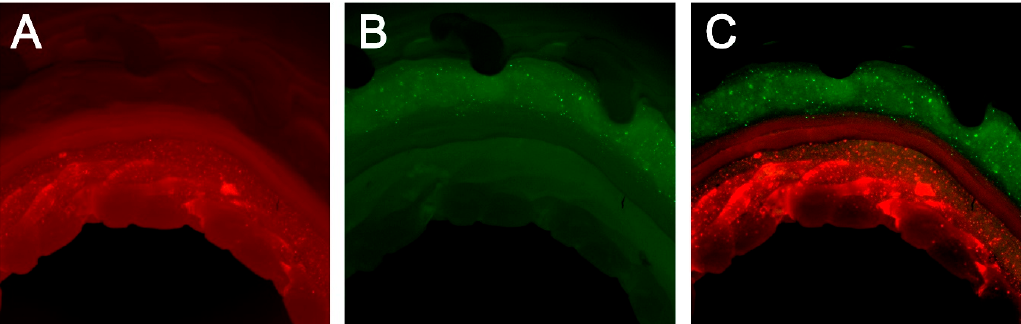
Figure 3. Cell distribution in alginate hydrogel with CellTracker™. ( A ) Epithelial cell in the second alginate hydrogel layer (red). ( B ) MSC in fourth alginate hydrogel layer (green). ( C ) A and B (merged). Each cell was well-printed layer by layer and separated completely.